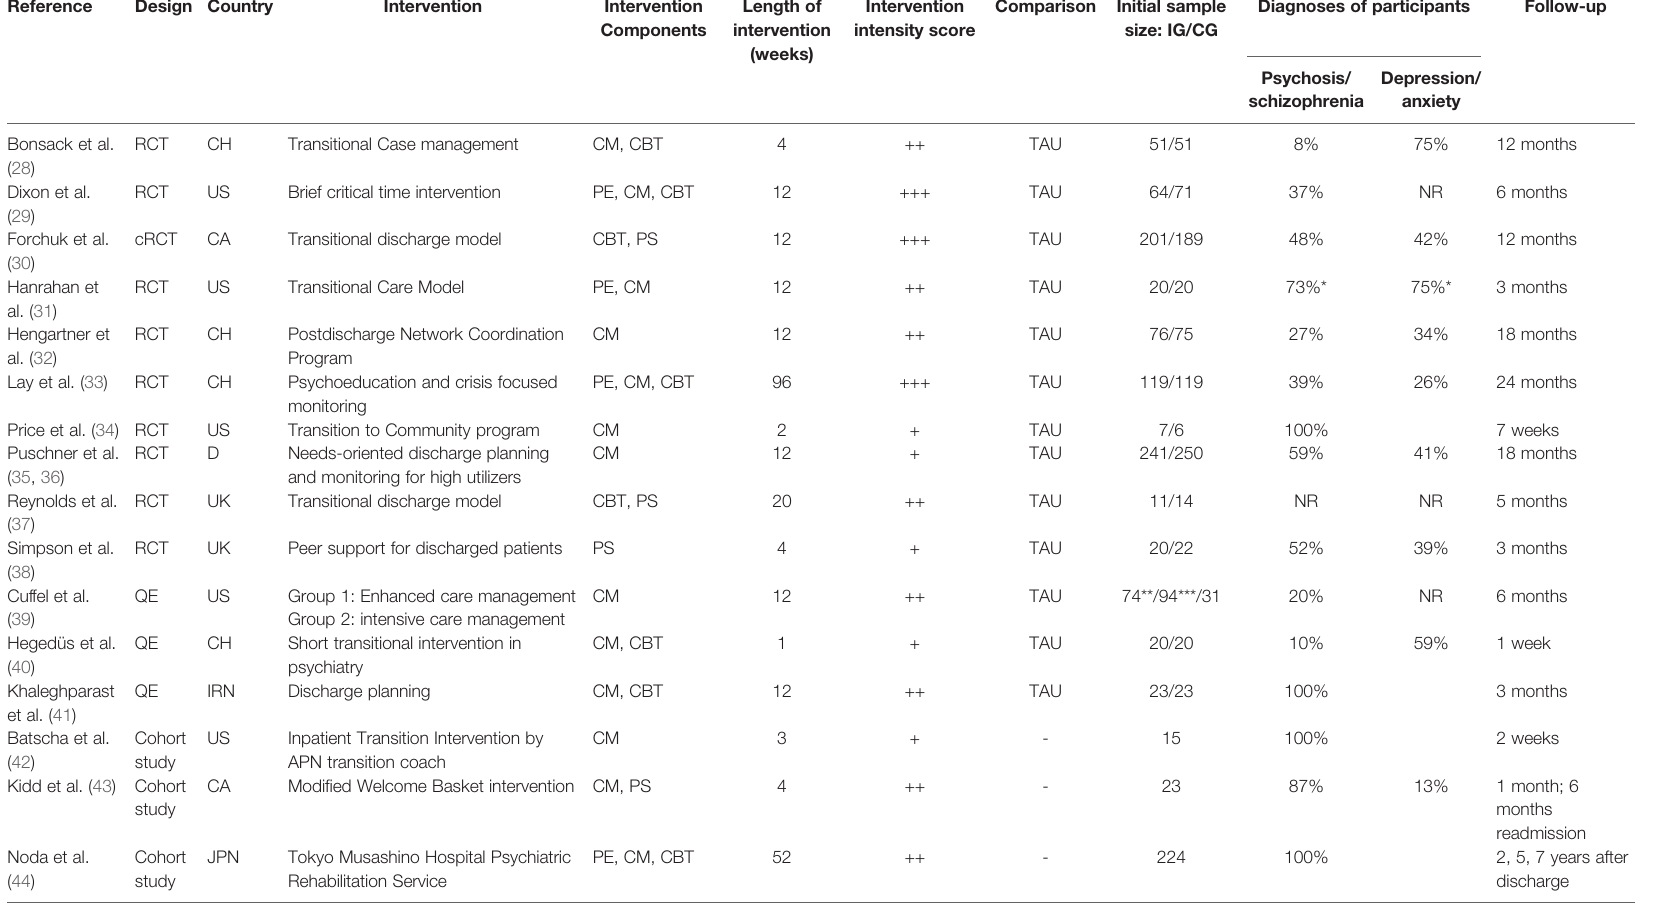
TABLE 1 | Description of included